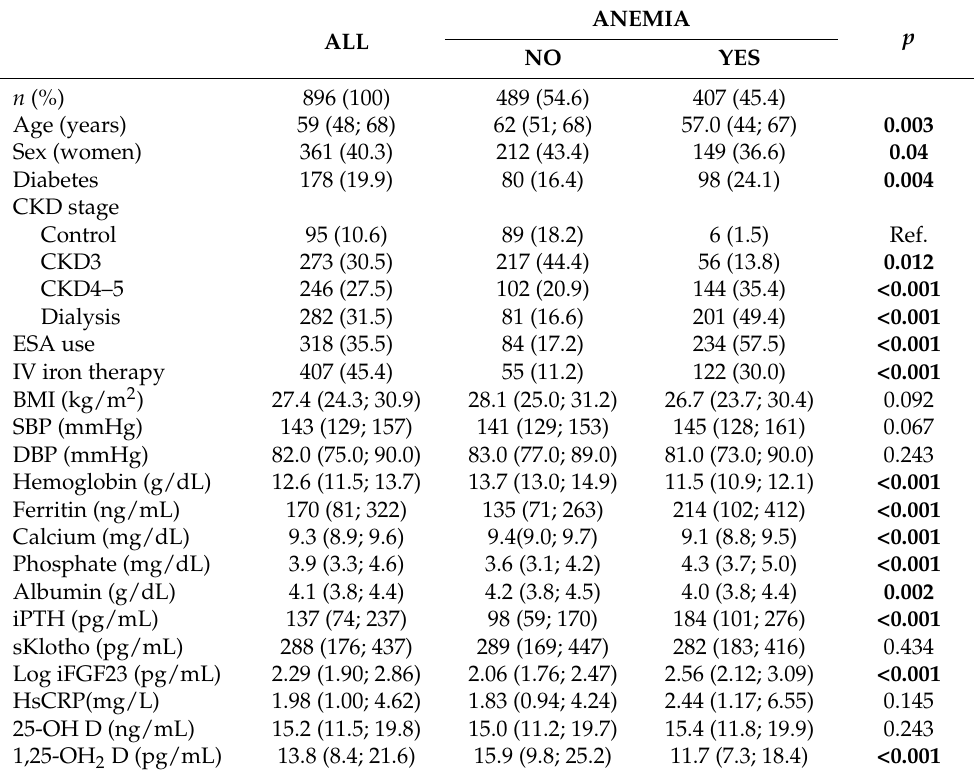
Table 1. Clinical and biochemical characteristics of the total subcohort and bivariate analysis of differences between patients with and without